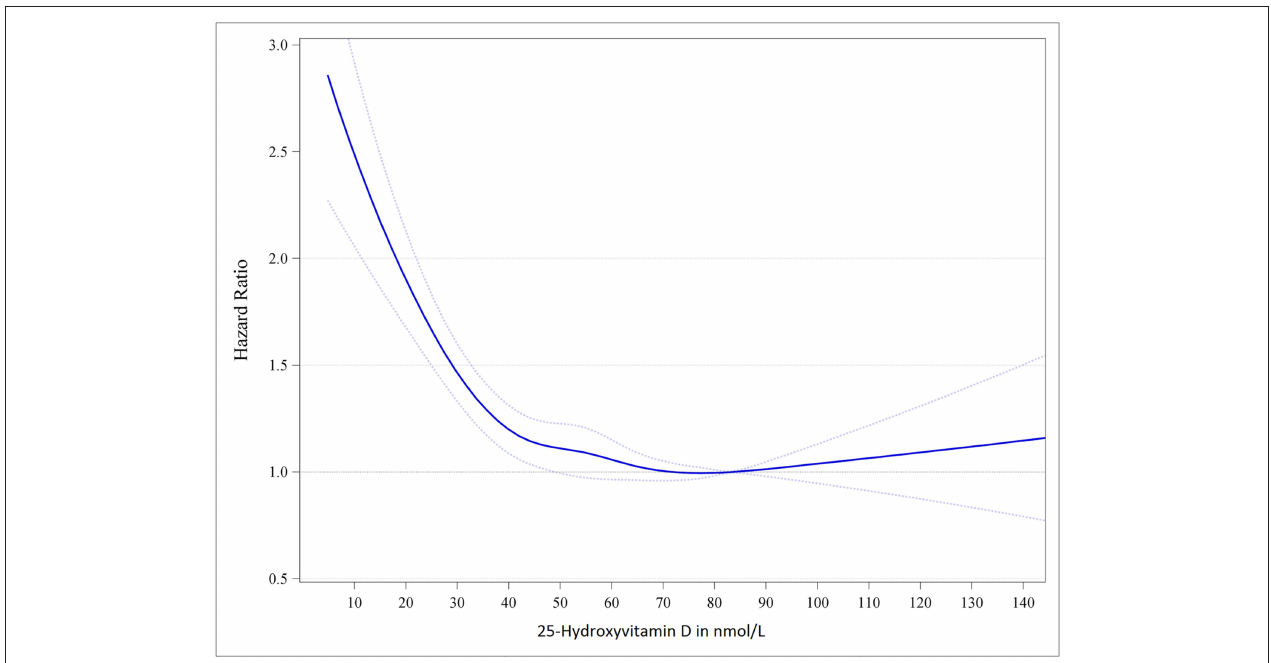
FIGURE 1 | Dose-response trend of hazard ratios of death from all causes by standardized serum 25-hydroxyvitamin D. Dose-response trend of hazard ratios of all-cause mortality by standardized 25-hydroxyvitamin D were adjusted for age, sex, body mass index and season of blood drawing concentrations. Hazard ratios (blue line with 95% confidence intervals as dotted blue lines) are referring to the 25-hydroxyvitamin D concentration of 83.4 nmol/L (i.e., the median 25-hydroxyvitamin D concentration of the group with 25-hydroxyvitamin D concentration from 75 to 99.99 nmol/L). Adopted from Gaksch et al.